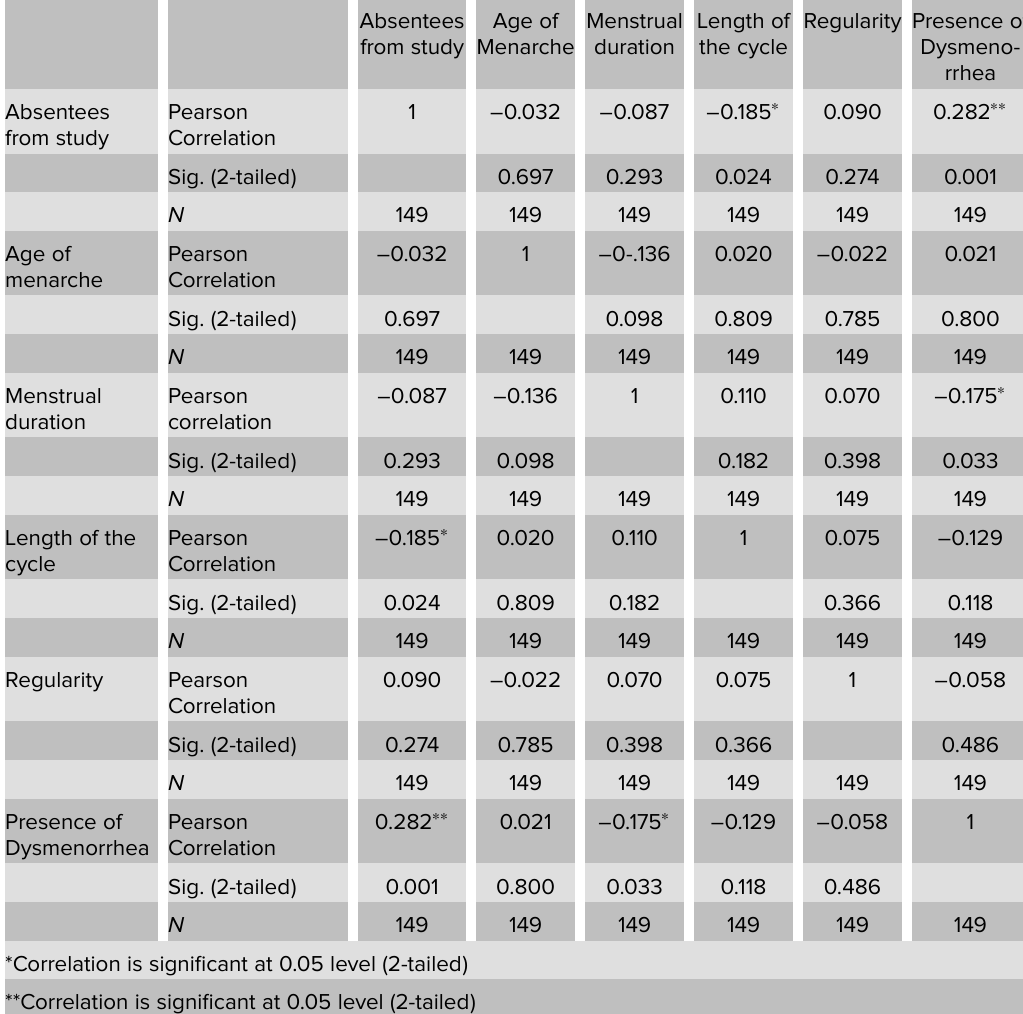
Absentees Age of from study